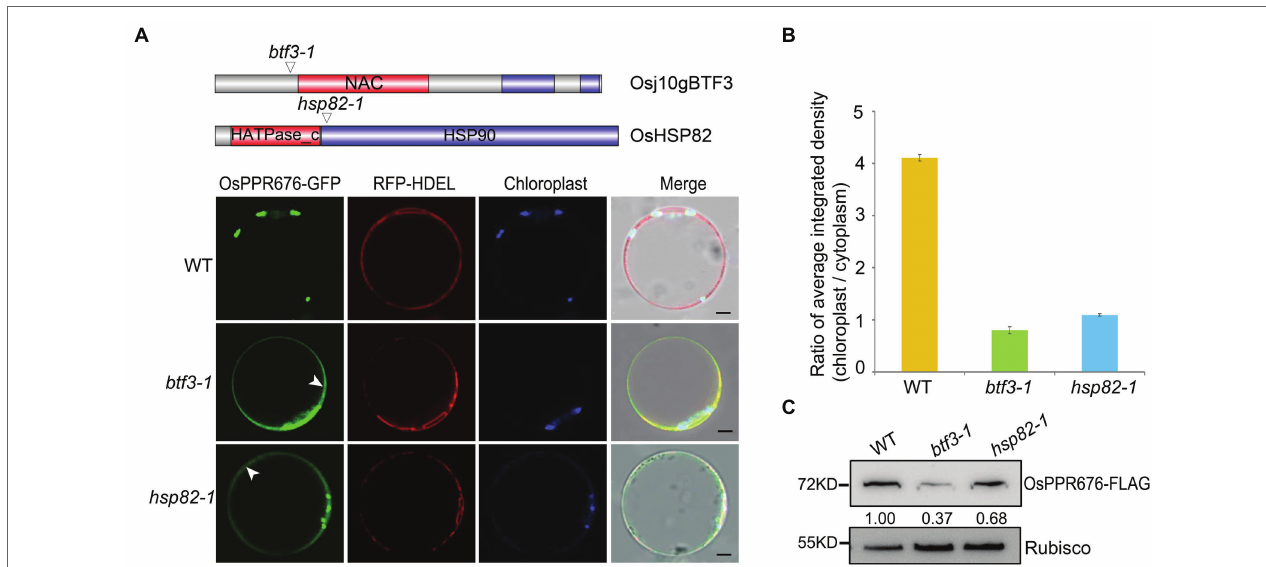
FIGURE 2 | Knockout of Osj10gBTF3/OsHSP82 reduces the accumulation of OsPPR676 in the chloroplast. (A) Structure of the Osj10gBTF3 and OsHSP82 proteins, the corresponding mutation sites and the subcellular localization of OPPR676 in WT, hsp82-1 , and btf3-1 mutant rice protoplasts, respectively. The white arrows indicate the ER or cytoplasm retention signals. Scale bar = 5 μ m. Two independent replicates were performed for each material. (B) Ratio of the chloroplast- integrated density to the cytoplasm-integrated density in WT, hsp82-1 , and btf3-1 mutants, respectively. Six cells were used to measure the average integrated density in each material. Values represent the mean ± SD, n = 3 independent replicates. (C) OsPPR676 protein in the chloroplast isolated from the protoplast of WT, hsp82-1 , and btf3-1 mutants was detected by FLAG antibody and measured quantitatively. Rubisco was used as an internal